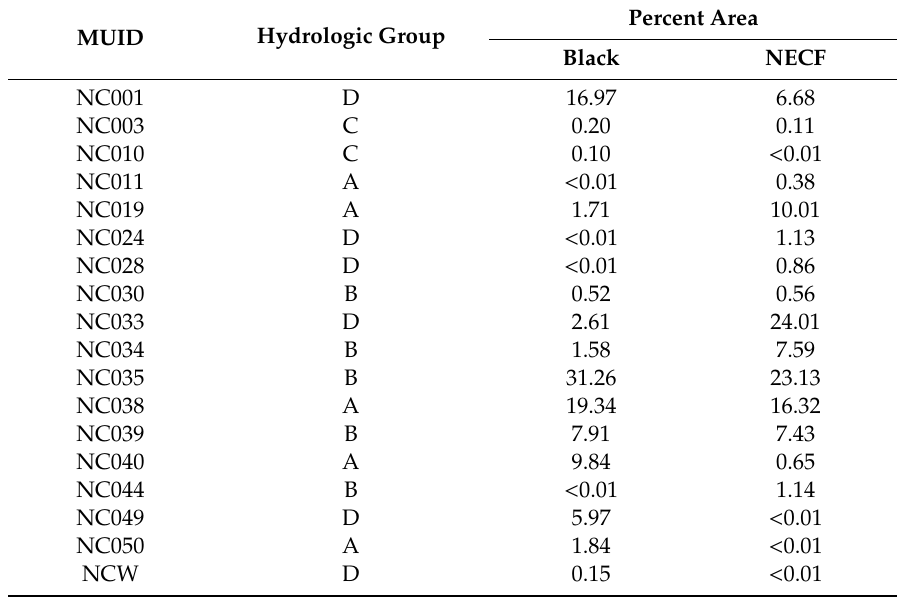
Table 2. State Soil Geographic Data (STATSGO) soil types in the Black and Northeast Cape Fear basins.